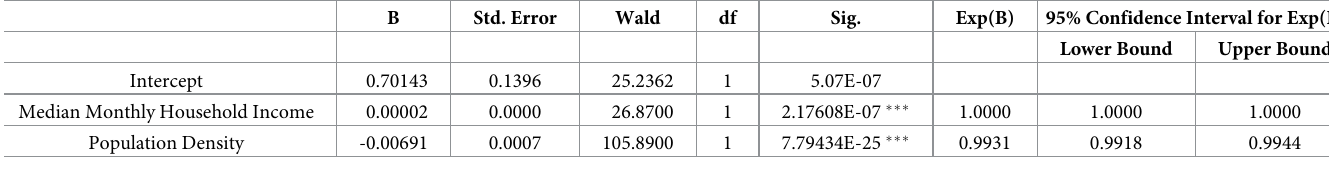
Table 3. Multinomial logistic regression analysis of the doubly disadvantaged